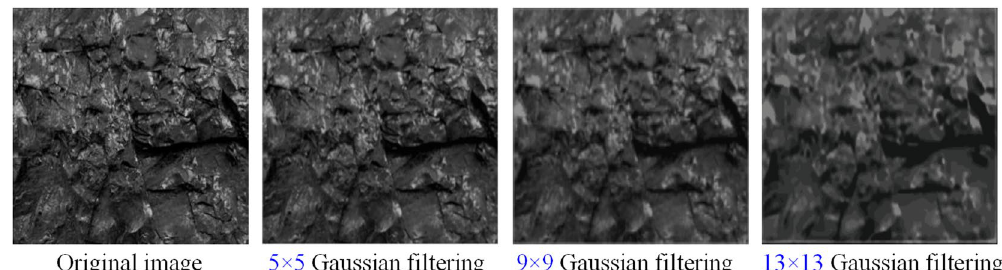
Figure 5. Processing results of coal ash image by Gaussian